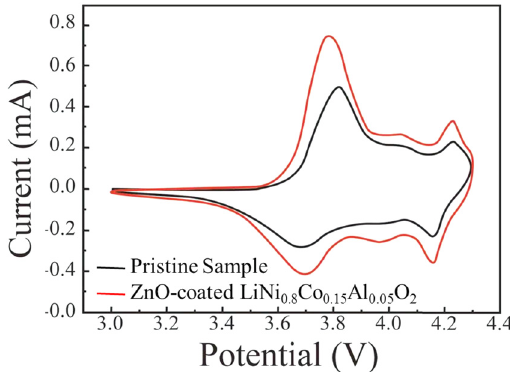
Figure 9: Rate performance of pristine and ZnO - coated LiNi 0.8 Co 0.15 Al 0.05 O 2 samples.